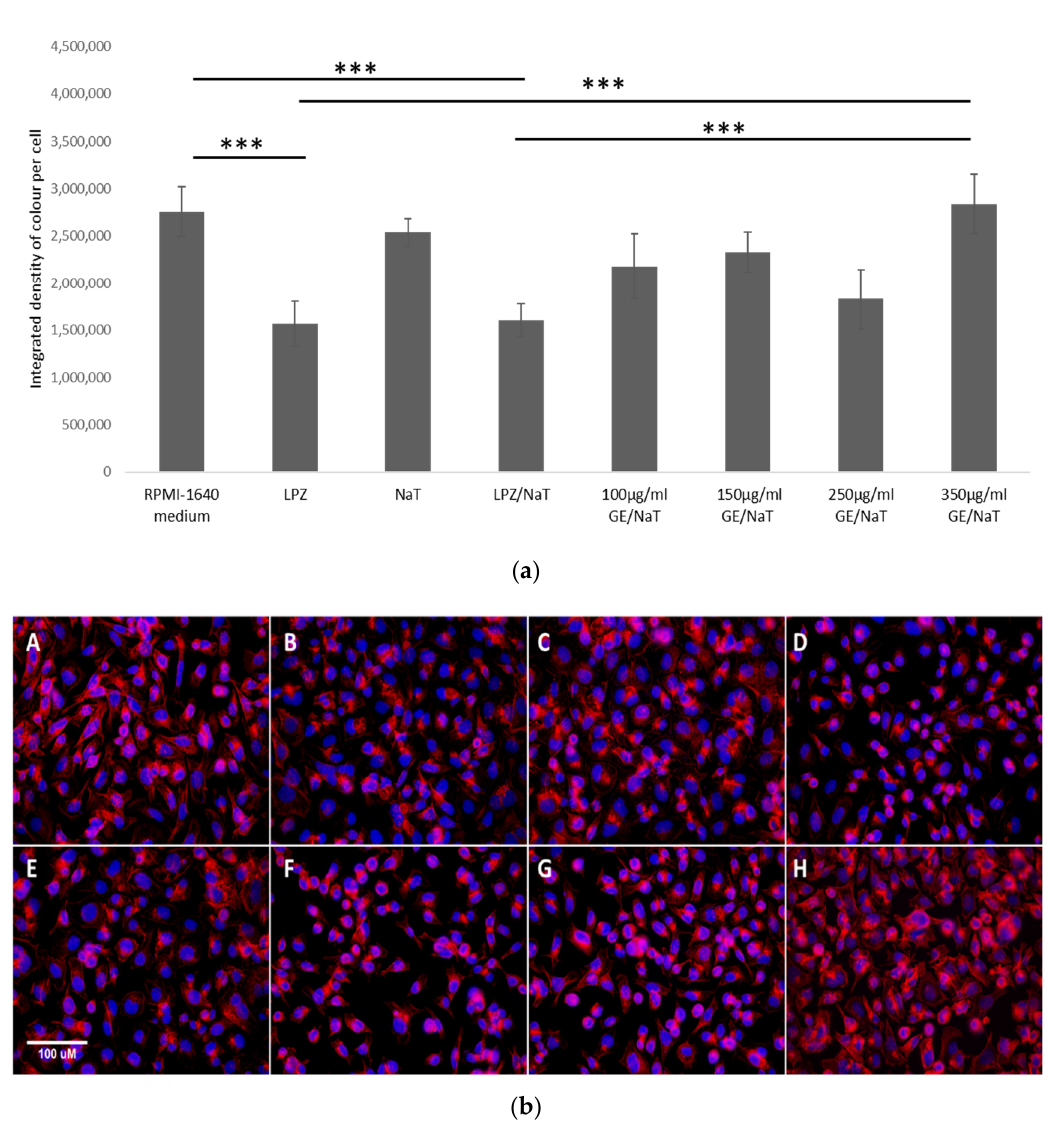
Figure 5. Quantification and Visualization of the F-actin cytoskelet with Rhodamine Phalloidin stain. ( a ) Levels of total F actin stained by Rhodamine Phalloidin treated with LPZ, NaT and GE in AGS cell line. Data represent integrated density of red color of stained actin per single cell. Higher number equals more intense stain. One-way ANOVA F(7,32) = 18.47, p = 1.37 × 10 − 9 . The values are represented as means ± SD. Bars assigned with asterisks are statistically significantly different (*** p < 0.001) The data shown are representative of at least three independent experiments. Sodium taurocholate (NaT/4 mM), lansoprazole (LPZ/10 µM), garlic extracts (GE/100, 150, 250 and 350 µg/mL). ( b ) AGS cells were labeled for F-actin using Rhodamine Phalloidin and nuclei stained with DAPI. A- RPMI 1640 (control), B- lansoprazole (LPZ 10 µm), C- sodium taurocholate (NaT/4 mM), D- sodium taurocholate (NaT 4 mM) and lansoprazole (LPZ 10 µM), E- sodium taurocholate (NaT 4 mM) and garlic extracts (GE 100 µg/mL), F-sodium taurocholate (NaT 4 mM) and garlic extracts (GE 150 µg/mL), G -sodium taurocholate (4 mM) and garlic extracts (GE 250 µg/mL), H- sodium taurocholate (4 mM) and garlic extracts (GE 350 µg/mL). Size bar represents 100 µm.